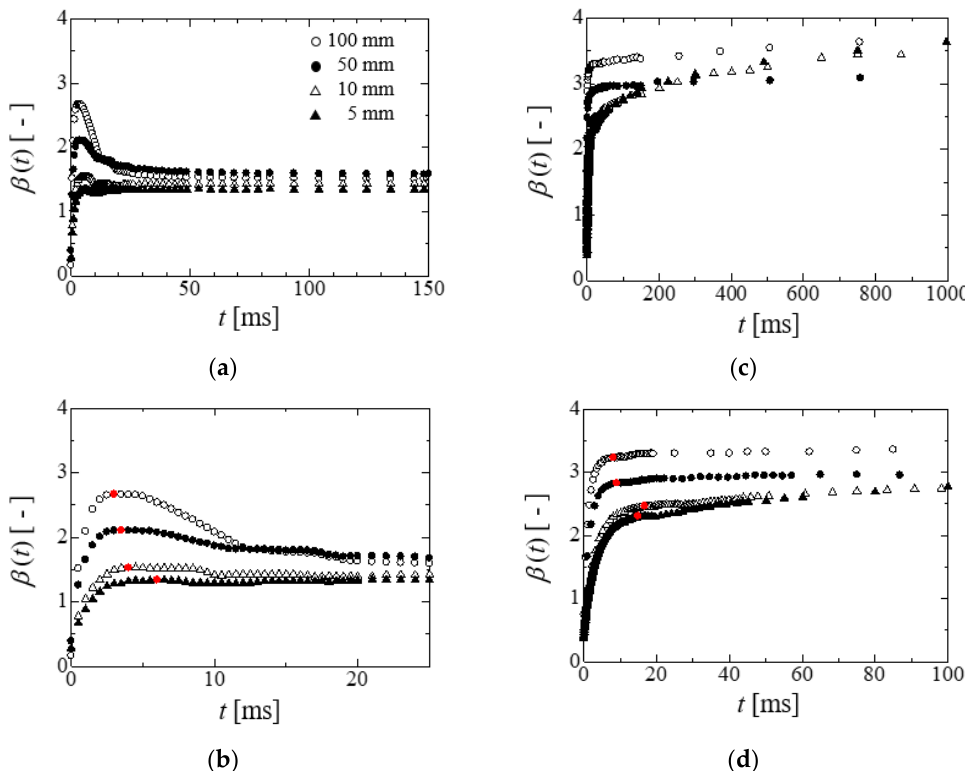
Figure 1. Time evolution of dimensionless contact area diameter β ( t ): ( a ) 0 wt% on bare substrate; ( b ) magnified image for 0 wt% on bare substrate in ( a ); ( c ) 70 wt% on #400 substrate; and ( d ) magnified image for 70 wt% on #400 substrate in ( c ).